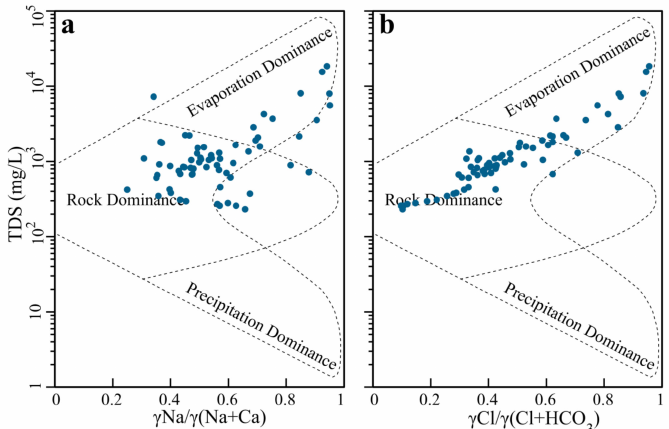
Figure 7. Gibbs diagram of groundwater chemical composition in the Shizuishan